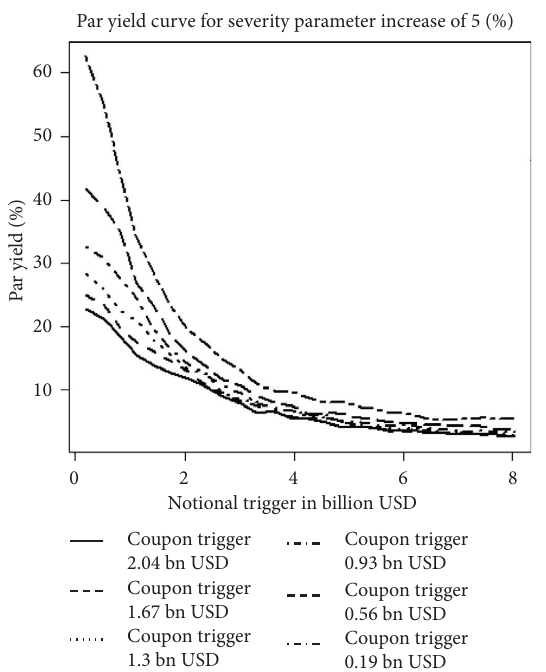
Figure 26: Cyber bond spread for loss frequency parameter λ increase of